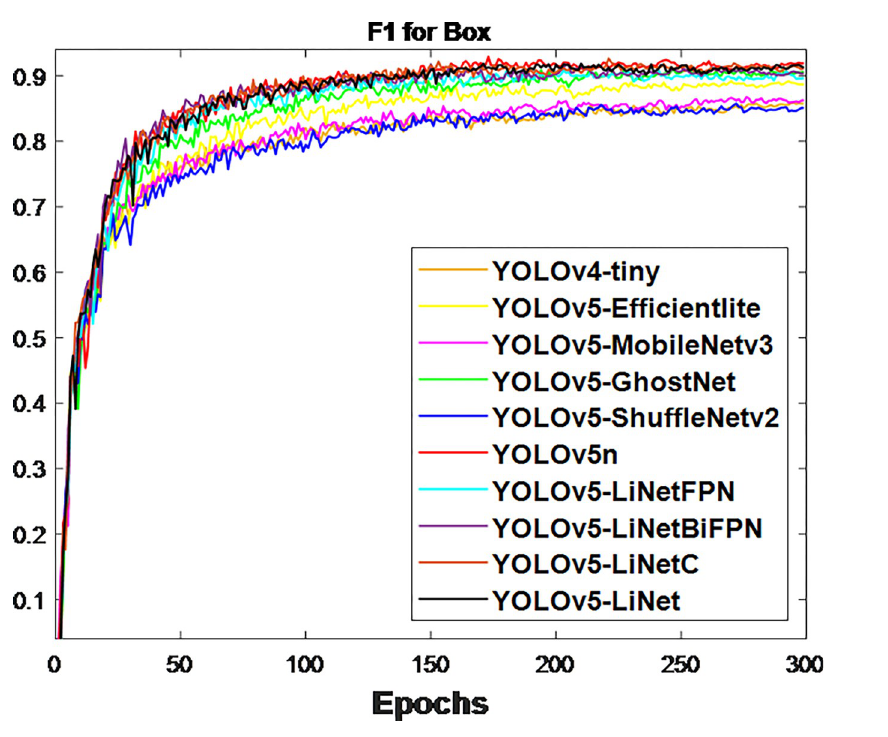
Fig 5. Output for box F 1